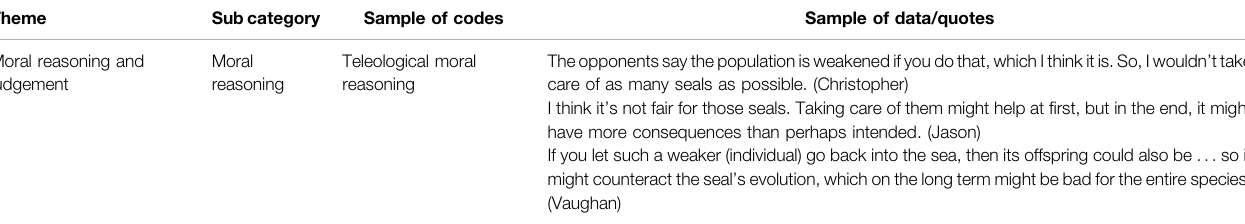
TABLE 4 | Exemplary comparison of three students ’ “ teleological moral reasoning ”